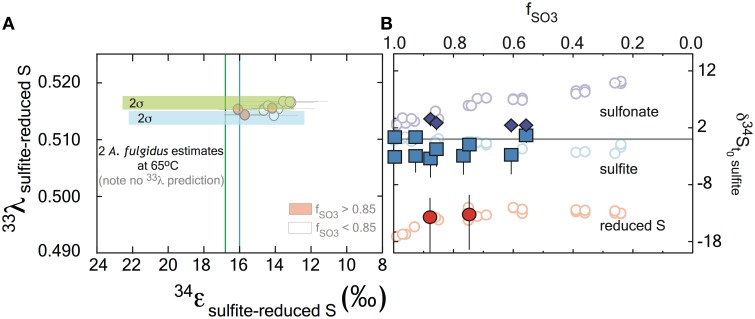
The major isotope ratios (δ34S) reported relative to the composition of sulfite at t0, for the A. fulgidus (closed symbols) and D. vulgaris (open symbols) experiments both as a function of reaction progress. The samples sets show a general consistency, particularly at the reduced S sites, despite the significant offet in temperature (20–30°C for D. vugaris relative to 65°C for A. fulgidus), consistent with kinetic theory (Bigeleisen and Wolfsberg, 1958), where temperature should impart a minimal effect over this range. The asymmetric error bars on reduced S moieties are a function of the non-linear correction for small sample sizes available for isotope.